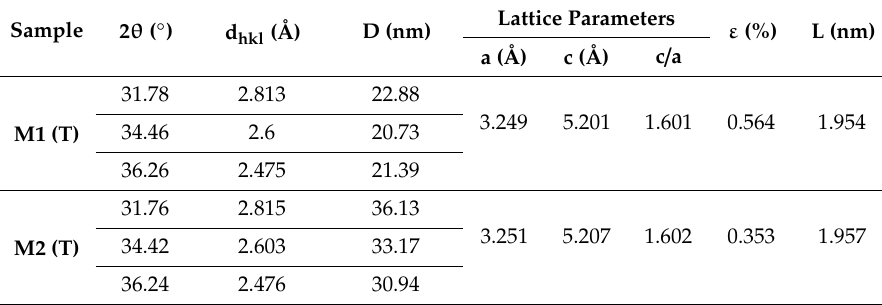
Table 1. Structural parameters of carbon / ZnO nanostructured